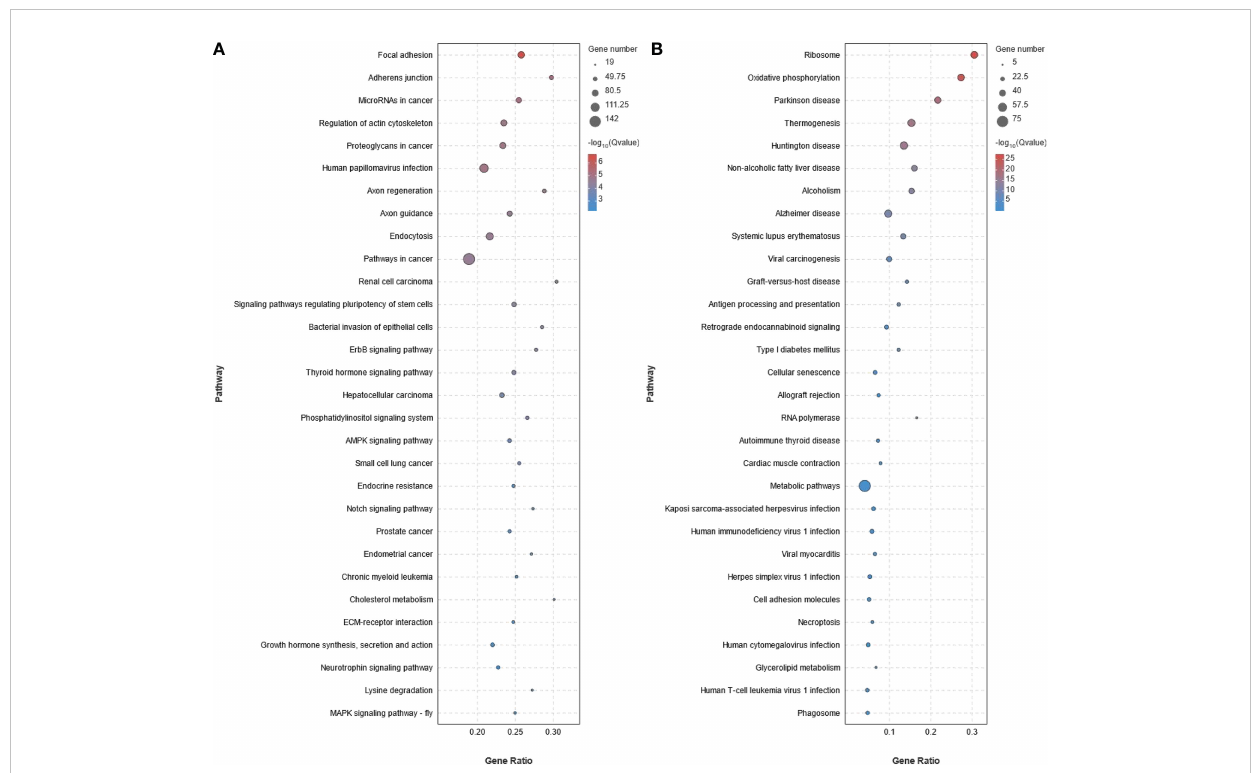
FIGURE 5 KEGG pathway enrichment analysis of the differentially expressed genes (DEGs) obtained from RNA-seq data of stage III and IV ovary of S. argus . (A) Up-regulated DEGs. (B) Down-regulated DEGs. The diameter of the circles represents the number of genes. The colors bar, from red to blue, represents the signi fi cance level of